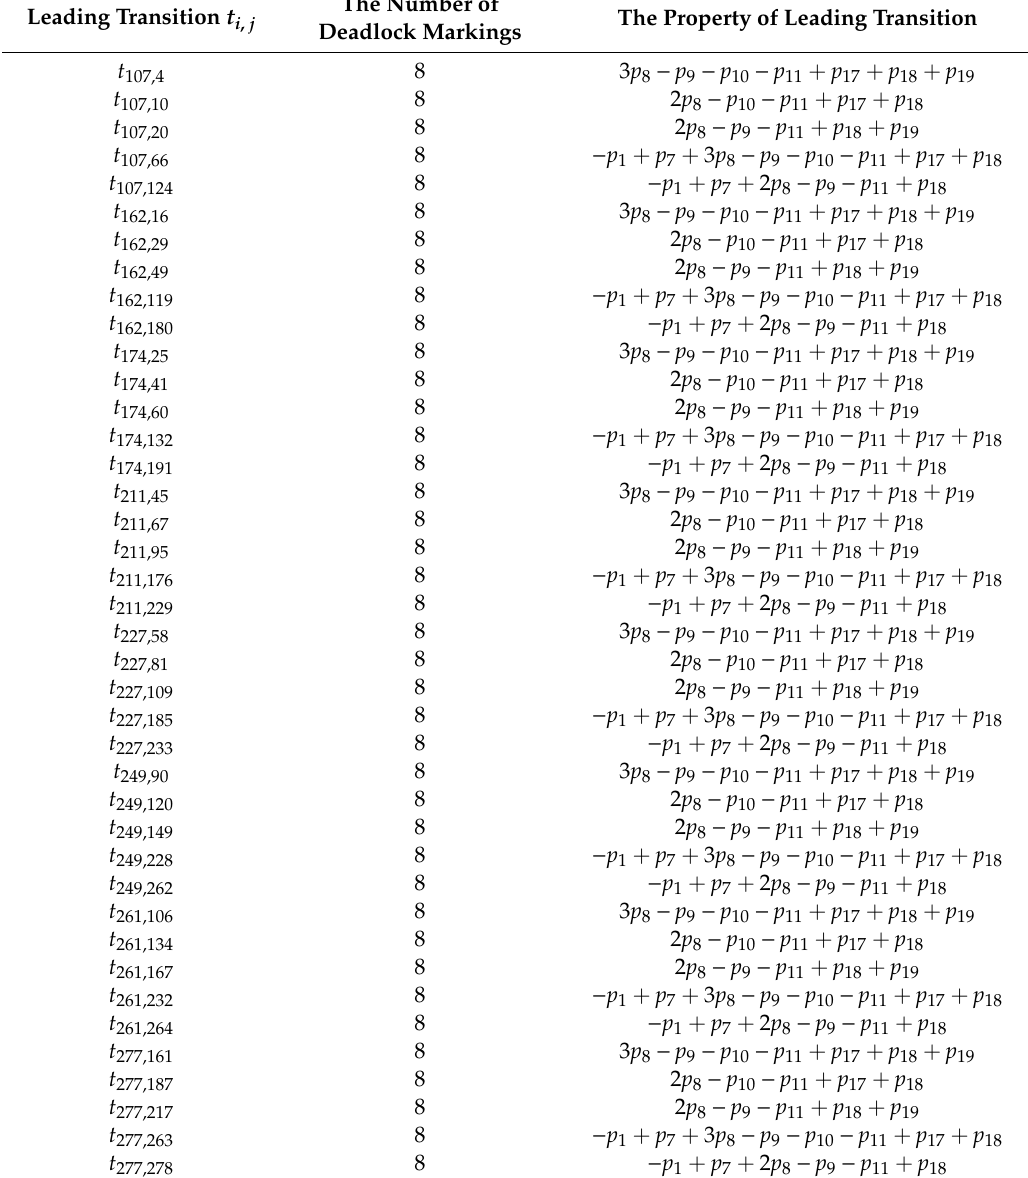
Table 6. The detailed information of all leading transition of Example 2 in first iteration. The Number of Leading Transition t i , j Deadlock